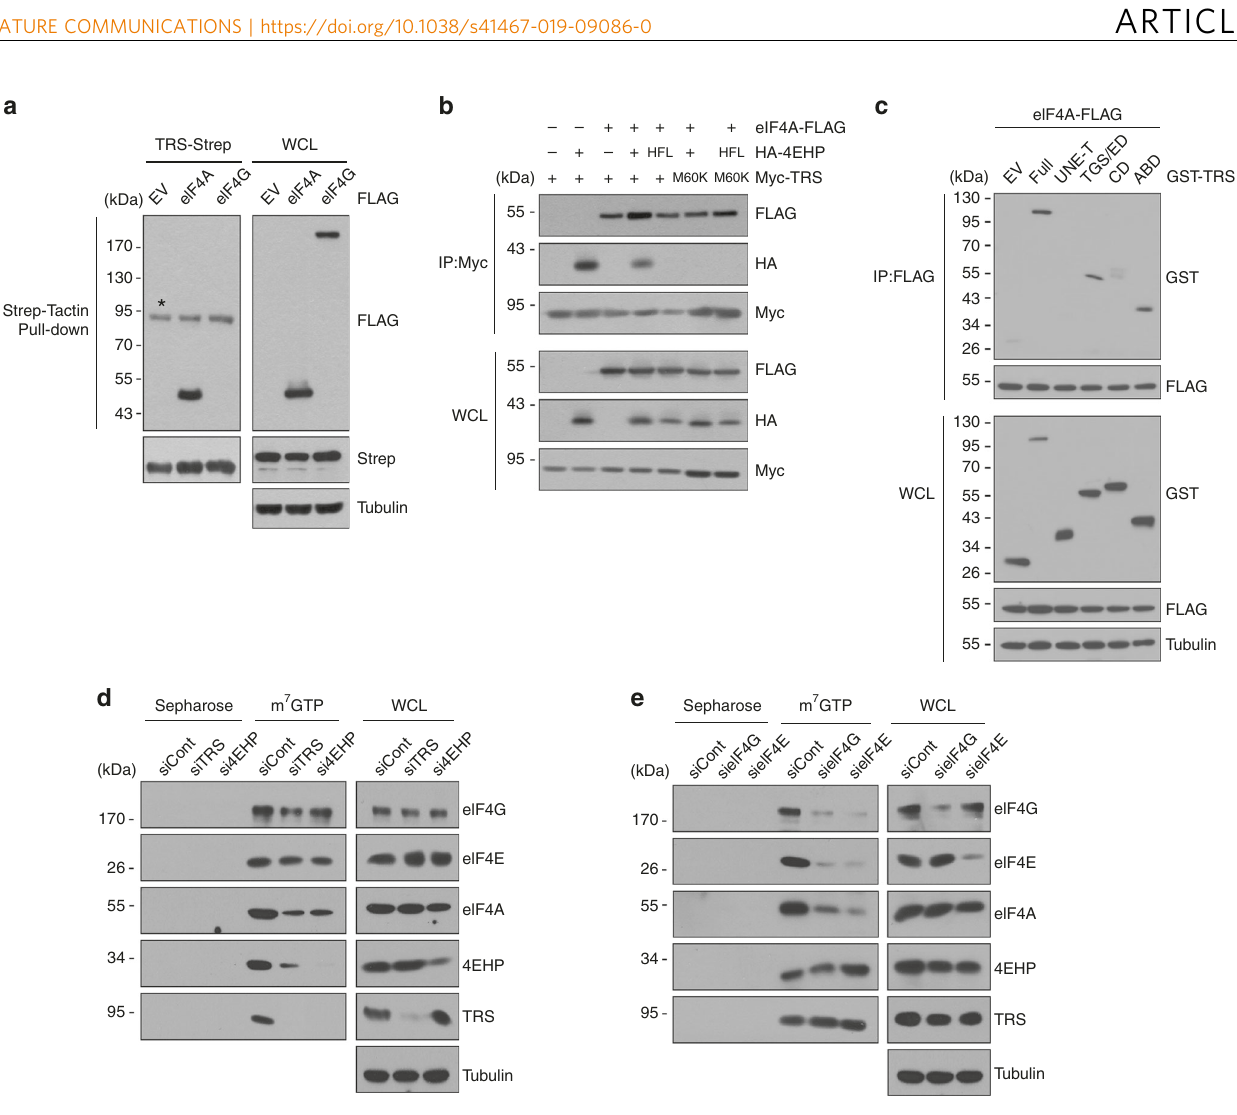
Fig. 6 TRS functions similarly to eIF4G and acts as an eIF4F analog. a Pull-down assay of co-expressed TRS-Strep with eIF4A- or eIF4G-FLAG in 293 T cells. TRS-Strep was pulled down with Strep-Tactin beads, and co-precipitation of eIF4A or 4 G was determined by immunoblotting with anti-FLAG antibody. EV, empty vector. * indicates a nonspeci fi c band. b Immunoassay of the co-expression of different combinations of plasmids in 293T cells. Myc-TRS was immunoprecipitated with anti-Myc antibody, and co-precipitation of other proteins was determined using tag-speci fi c antibodies. c Immunoassay of co- expressed eIF4A-FLAG with GST-fused full-length TRS or its various domains in 293T cells. eIF4A-FLAG was immunoprecipitated with anti-FLAG antibody, and co-precipitated TRS proteins were determined by immunoblotting with anti-GST antibody. d Pull-down assay of endogenous translation initiation factors with m 7 GTP-Sepharose beads in 293 T cells transfected with siRNAs against TRS, 4EHP, or a non-targeting control (siCont). Cap-bound proteins were eluted from beads and immunoblotted with the indicated antibodies. Sepharose beads were used as a negative control. e Pull-down assay of endogenous translation initiation factors with m 7 GTP-Sepharose beads in 293T cells transfected with siRNAs against eIF4G, eIF4E, or siCont, and their suppression effects on cap-binding of other components, were determined as in ( d ). The data are representative of at least three experiments, each